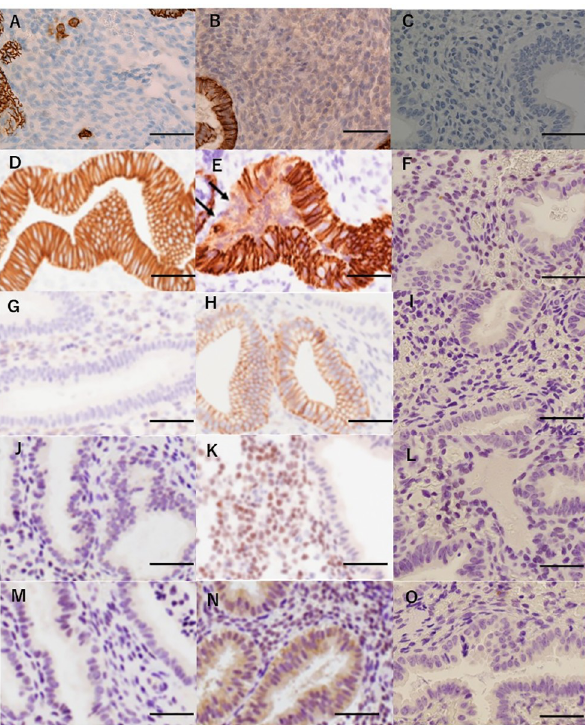
Fig 2. Results of the immunohistochemical analysis of the specimens. (A) Endometrium diagnosed with chronic endometritis. The infiltration of CD138-positive plasma cells was detected in the stromal area of the endometrium by immunohistochemistry. (B) Endometrium diagnosed with non-chronic endometritis. No plasma cells were detected in the stromal area of the endometrium by immunohistochemistry for CD138. (C) Endometrium without CD138 antibody staining. No staining was detected in the endometrium. (D) Endometrium without a loss of E-cadherin. The expression of E-cadherin was detected in all the glandular cells in endometrial specimens. (E) Endometrium with a loss of E-cadherin. A cluster of endometrial glandular cells without E-cadherin staining was observed (arrows). When such a finding was detected, it was judged as a loss of E-cadherin. (F) Endometrium stained without E-cadherin antibodies. No staining was detected in the endometrium. (G) Endometrium without N-cadherin expression. The expression of N-cadherin was not detected in the glandular cells in endometrial specimens. (H) Endometrium with N-cadherin expression. Gain of N-cadherin staining was present in part of the endometrial glandular cells. When positive staining was observed, it was judged as a gain of N-cadherin expression. (I) Endometrium stained without N-cadherin antibodies. No staining was detected in the endometrium. (J) Endometrium without the expression of Slug. Slug was not expressed in the stromal cells of the endometrium. (K) Endometrium with the expression of Slug. Slug was expressed in the nuclei of endometrial stromal cells. When positive staining was observed, it was judged as Slug- positive. (L) Endometrium stained without Slug antibodies detected in the endometrium. (M) Endometrium without expression of Snail. The expression of Snail was not noted in the glandular cells of the endometrium. (N) Endometrium with the expression of Snail. The cytoplasmic expression of Snail was noted in the glandular cells of the endometrium. When positive staining was observed, it was judged as Snail-positive. (O) Endometrium stained without Slug antibodies. No staining was detected in the endometrium. Scale bar represents 50 μ m.